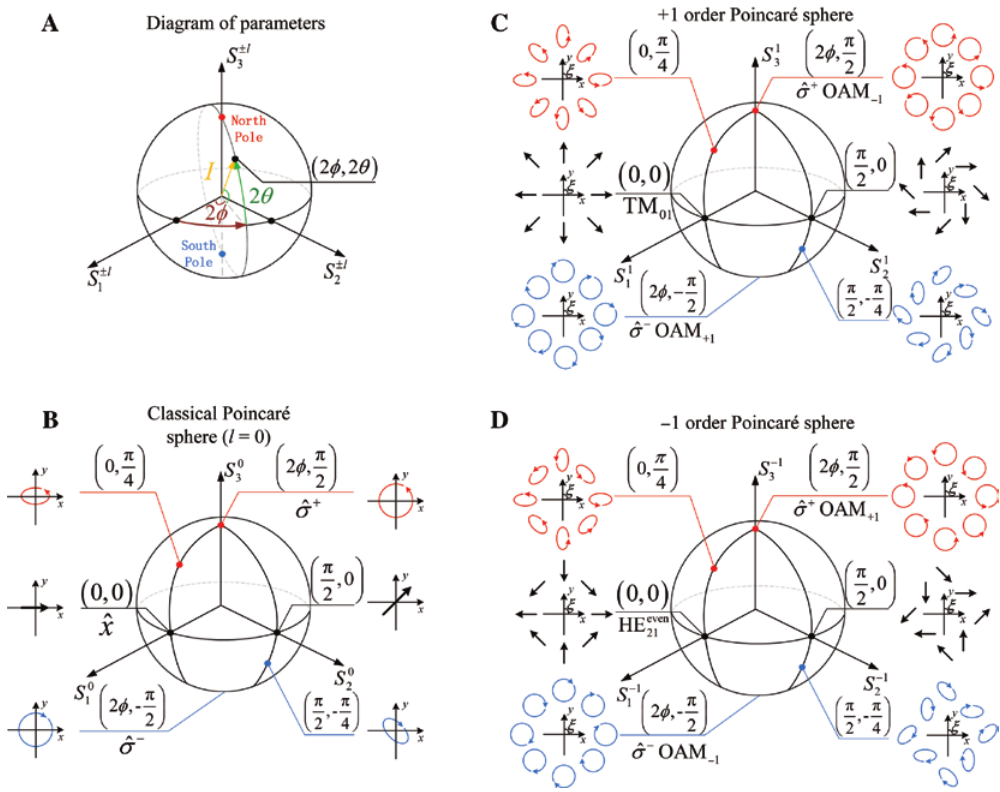
Figure 1: Poincaré spheres with different orders. (A) Diagram of Poincaré sphere depicting parameters. (B) Classical Poincaré sphere; and higher-order Poincaré sphere. (C) The + 1 order Poincaré sphere and (D) the −1 order Poincaré